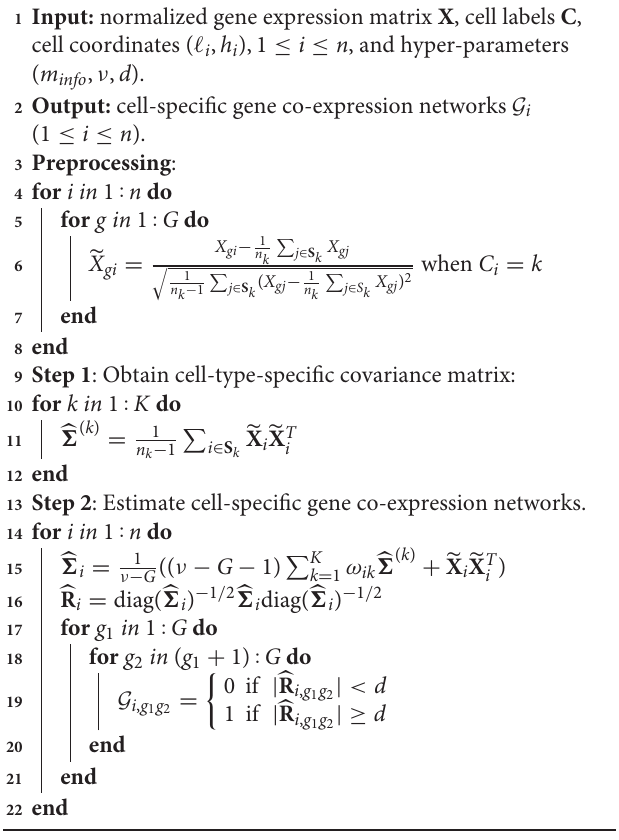
Algorithm 1: Two-step gene co-expression network estimation.